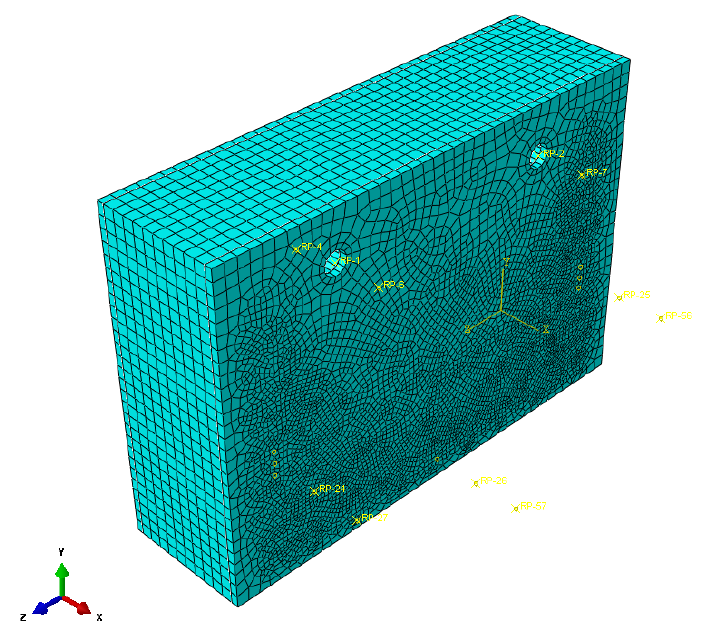
Figure 14. Mesh of the